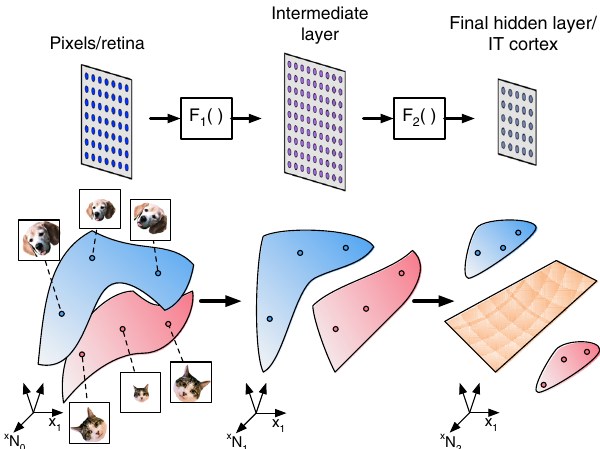
Fig. 1 Changes in the geometry of object manifolds as they are transformed in a deep neural network. Illustration of three layers in a visual hierarchy where the population response of the fi rst layer is mapped into intermediate layer by F 1 and into the last layer by F 2 (top). The transformation of per-stimuli responses is associated with changes in the geometry of the object manifold, the collection of responses to stimuli of the same object (colored blue for a ‘ dog ’ manifold and pink for a ‘ cat ’ manifold). Changes in geometry may result in transforming object manifolds which are not linearly separable (in the fi rst and intermediate layers) into separable ones in the last layer (separating hyperplane, colored